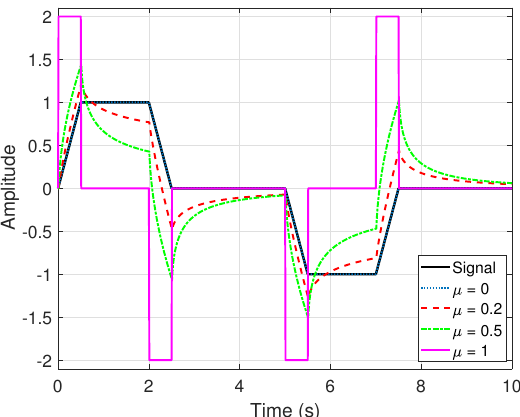
Figure 9. Effects of the derivative action according to differentiation order µ on a trapezoidal